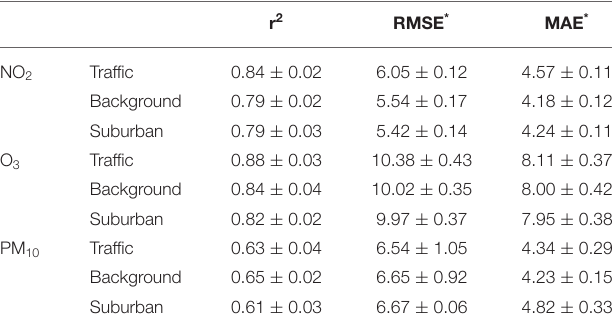
TABLE 2 | The results of the k-fold cross validation for the LightGBM model using 10 folds and displayed as the average value ± standard